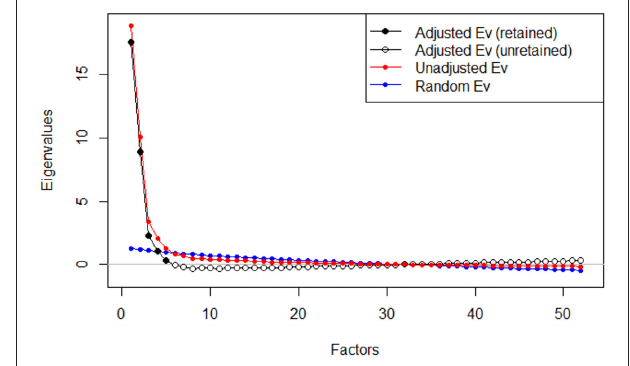
FIGURE 3 | Plot for Horn’s Parallel